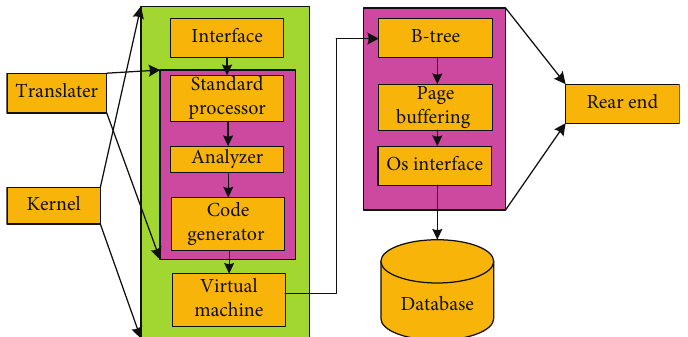
Figure 1: Structure of an SQLite